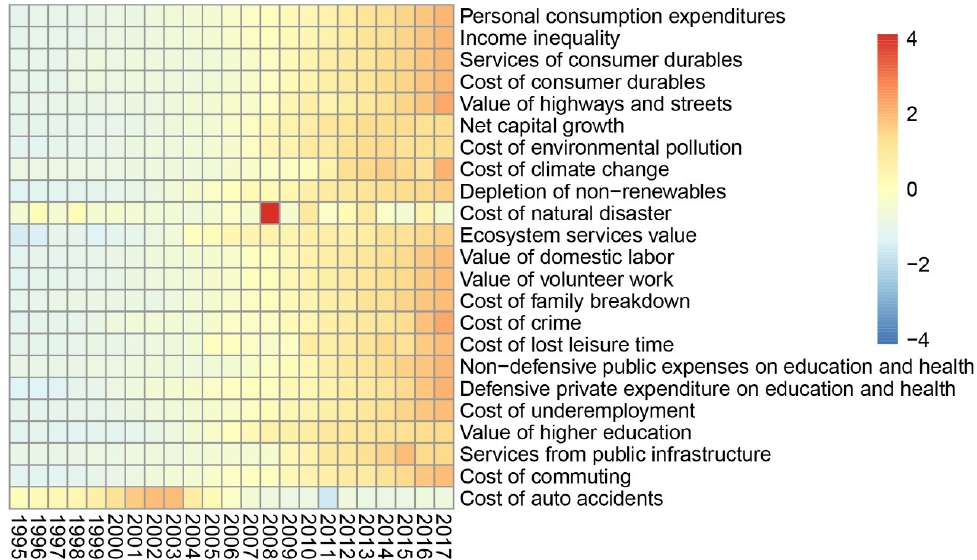
Figure 1. Change trends of standardized GPI indicators.